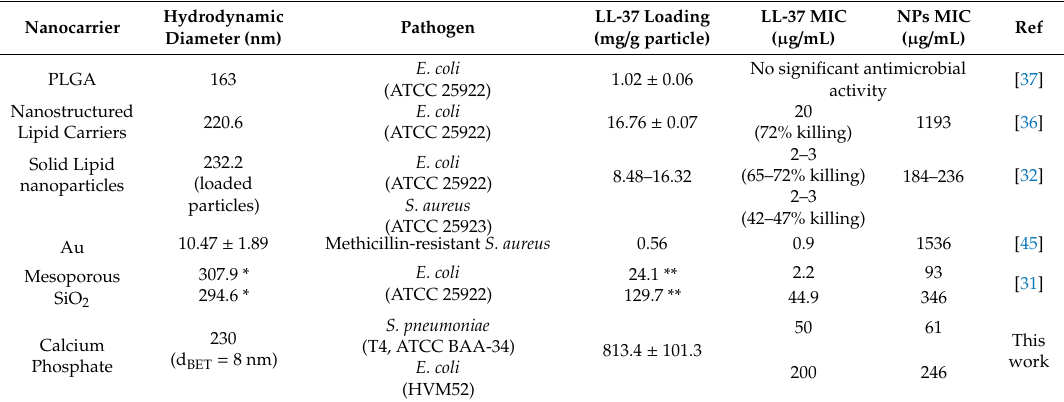
Figure 3. ( a ) E ff ect of concentration of BSA, bradykinin and LL-37 on the loading capacity of CaPs nanoparticles (pH 7.4, particle concentration 500 µ g / mL); ( b ) Loading capacity of CaPs nanoparticles for particle concentration 500 µ g / mL and macromolecule concentration (i.e., BSA, bradykinin and LL-37) 500 µ g / mL. Data are reported as mean ± standard deviation, for at least 3 independent triplicates. Table 2. LL-37 loading values for various nanocarriers of di ff erent sizes reported in the literature. LL-37 loading values achieved in the present study for CaP nanocarriers outperform all LL-37 loading values found in the literature. Minimum Inhibitory Concentration (MIC) values of LL-37 and of the nanoparticle dose for the presented nanocarriers are also shown.